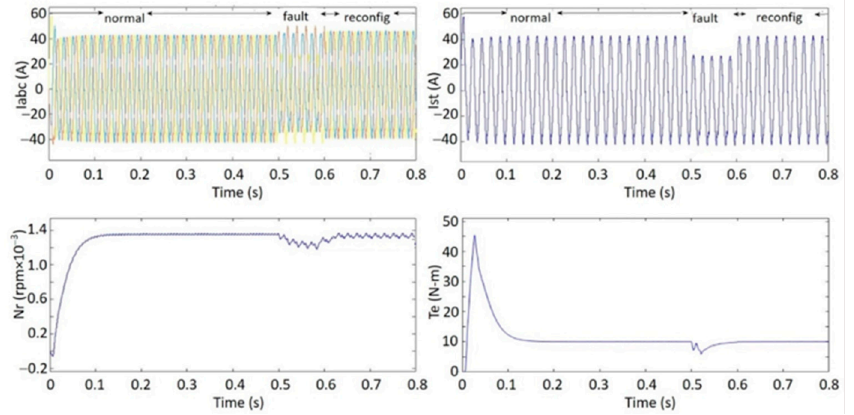
Figure 9. Simulation results during GSC fault and fault